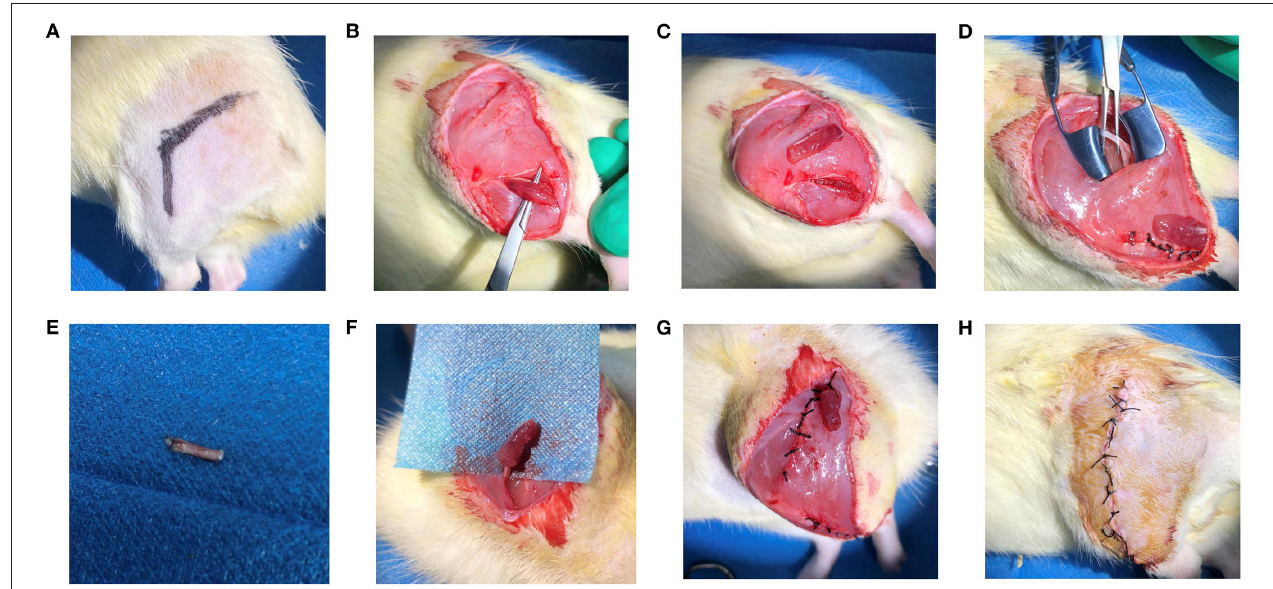
FIGURE 1 | (A) Confirm the surgical approach by exposing the lower limb skin of the rat. (B) Expose the extensor digitorum longus of the rat. (C) Cut off and acquire the appropriate size extensor digitorum longus. (D) Expose the sciatic nerve of the rat. (E) Transect the sciatic nerve of the rat. (F) Fix the nerve adventitia on the obtained free extensor digitorum longus muscle, and suture the muscle to wrap the nerve. (G) Suture the muscle space and fix the RPNI model under the skin. (H) Suture the skin and establish the RPNI model.